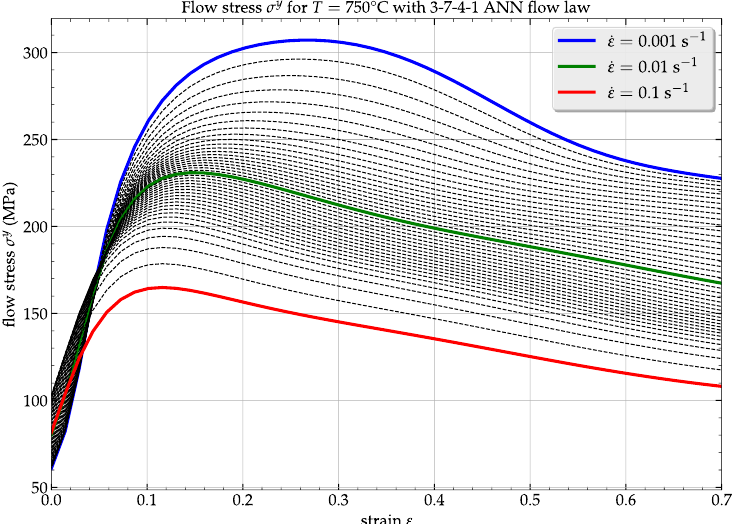
. ε ) for a fixed temperature T = 750 ◦ C using